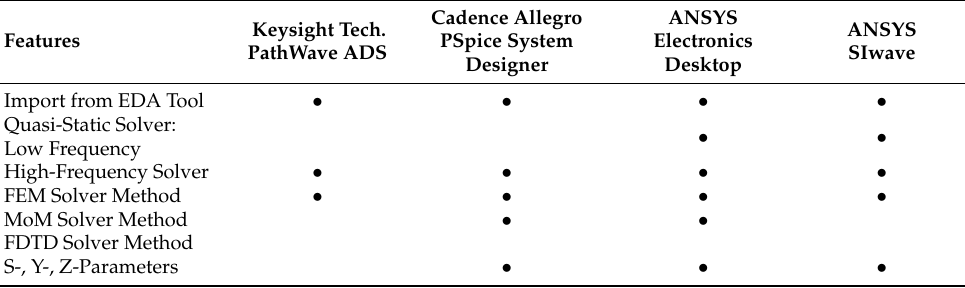
Table 3. Comparison of the main features software for 3D electromagnetic simulation.